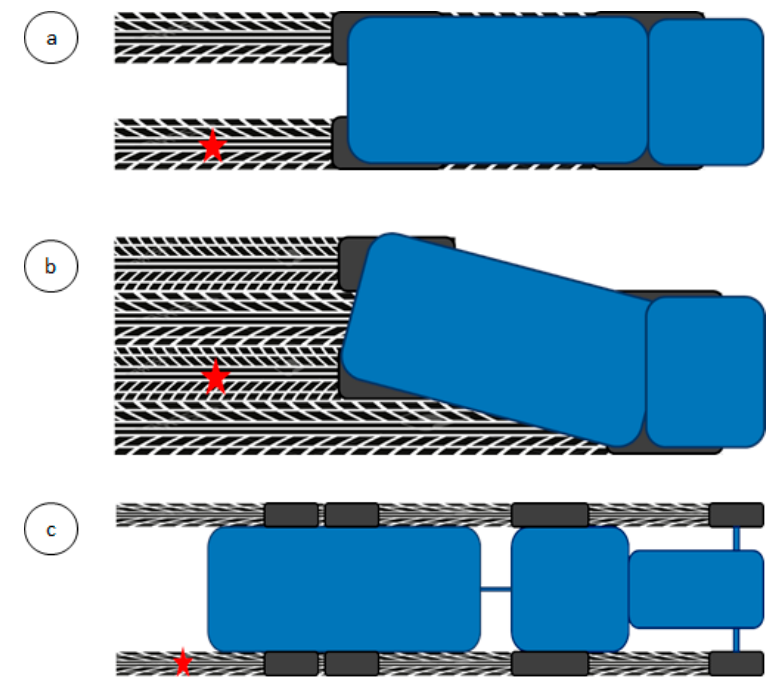
Figure 2. Conceptual drawings of the tested slurry application methods, showing the two steering modes of the self-propelled slurry spreader, i.e., standard steering, SP-S ( a ) and crab steering, SP-C ( b ) and the tractor-trailer combination with both high and low tyre inflation pressure, TT-H and TT-L, respectively ( c ). The red star locates the position where the undisturbed soil samples were taken, and the penetration resistance was measured. This position corresponds with the centre of the tyre track that was driven over by, at least, the rear axle. Table 2. Tyre properties and wheel load for each axle of the four slurry application methods. The numbering of the axles is given from front to rear.